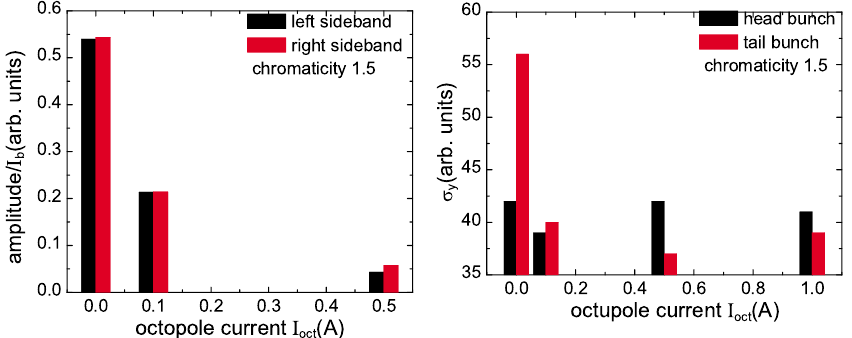
FIG. 11. (Color) Amplitude of the sideband (left) and the bunch size (right) versus octupole